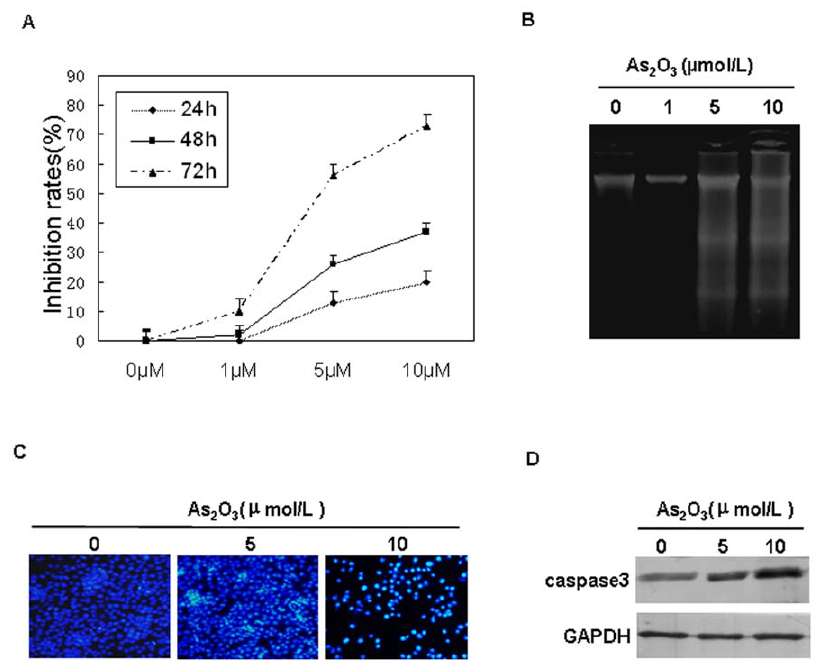
Figure 1. Arsenic trioxide (As2O3)-induced growth inhibition and apoptosis of gastric cancer FU97 cells. (A ) Cellular growth inhibition measured by MTT assay. Data are mean 6 SD of 3 independent experiments. (B) Agarose gel analysis of DNA fragmentation in FU97 cells treated with As2O3 for 72 h.(C) Apoptotic nuclei stained with Hoechst 33258 show intense fluorescence corresponding to chromatin condensation and fragmentation.(D) Western blot analysis of caspase3 protein in total cell extracts of FU97 cells treated with the indicated concentration of As2O3 for 72 h. GAPDH expression served as loading control.